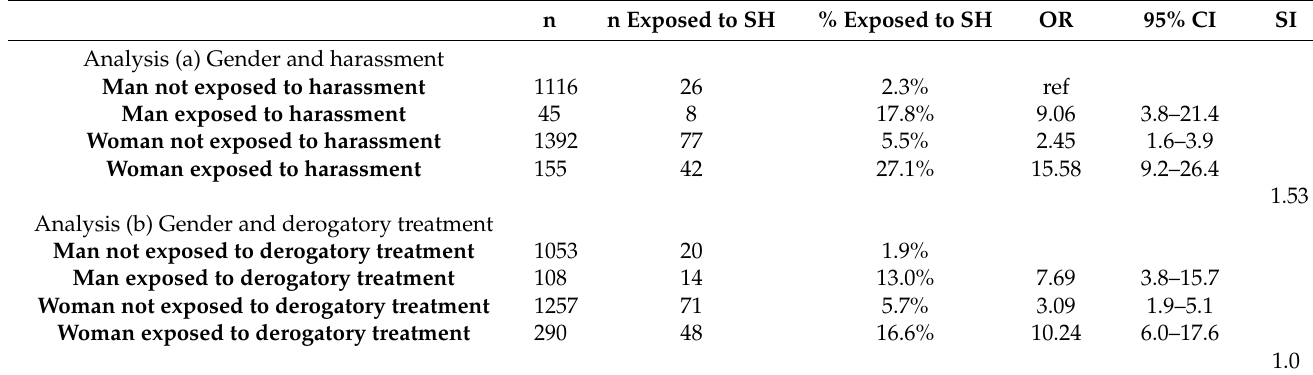
Table 7. Interaction between gender and harassment *, and gender and derogatory treatment, regarding sexual harassment at Lund